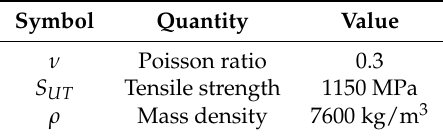
Table 1. Properties of the FeCrCo 48/5 SHMM